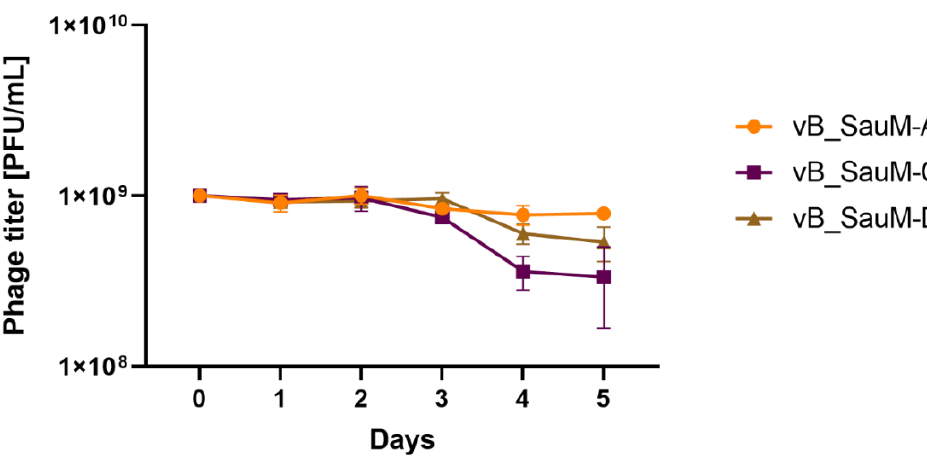
Figure 1. Influence of lactoferrin (10 mg/mL) on phage titer during storage period. Arithmetic mean of triplicates, with error bars representing SD.